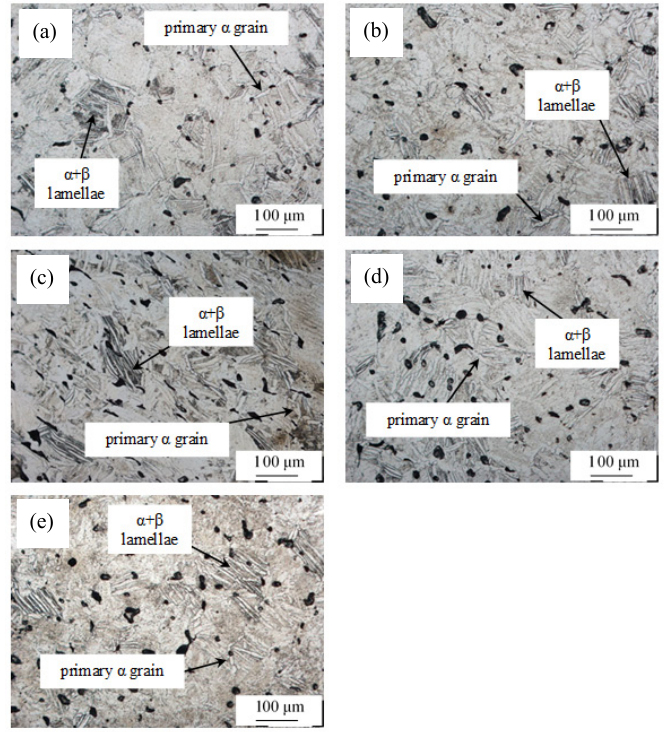
Figure 1. Microstructure of the Ti-5Al-2.5Fe billets forged at 950 °C subjected to β annealing at 750 °C with different aging times: ( a ) 2 h, ( b ) 4 h, ( c ) 6 h, ( d ) 8 h, and ( e ) 10 h. From the analysis of the evolution of the microstructure of the Ti-5Al-2.5Fe alloy forged at 1250 °C with the annealing heat treatment time (Figure 2), it can be seen that alloy is characterized by a fine lamellar microstructure, which coarsens as the annealing time increases. It can also be seen that the annealing at 750 °C, thus within the two-phase α + β region, leads to the nucleation and growth of α Ti grain boundaries, which start to be distinguishable in the microstructure after 6 h of annealing heat treatment (Figure 2c). Although both alloys experience a coarsening of the microstructural features, the Ti-5Al- 2.5Fe alloy forged at 1250 °C has a significantly finer microstructure in comparison with the Ti-5Al-2.5Fe alloy forged at 950 °C. Furthermore, coherently with the microstructure of the forged alloys, the former is fully dense, and the few small pores present are not affected by the annealing heat treatment.